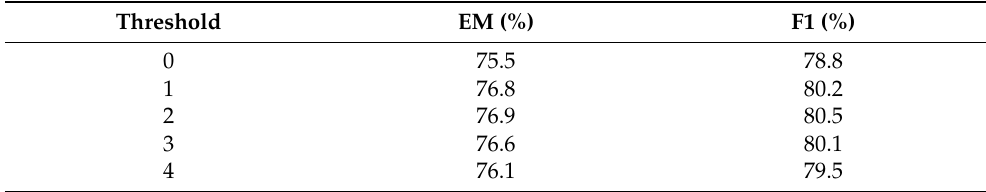
Table 5. Impact of the threshold of GD on the performance of the model.